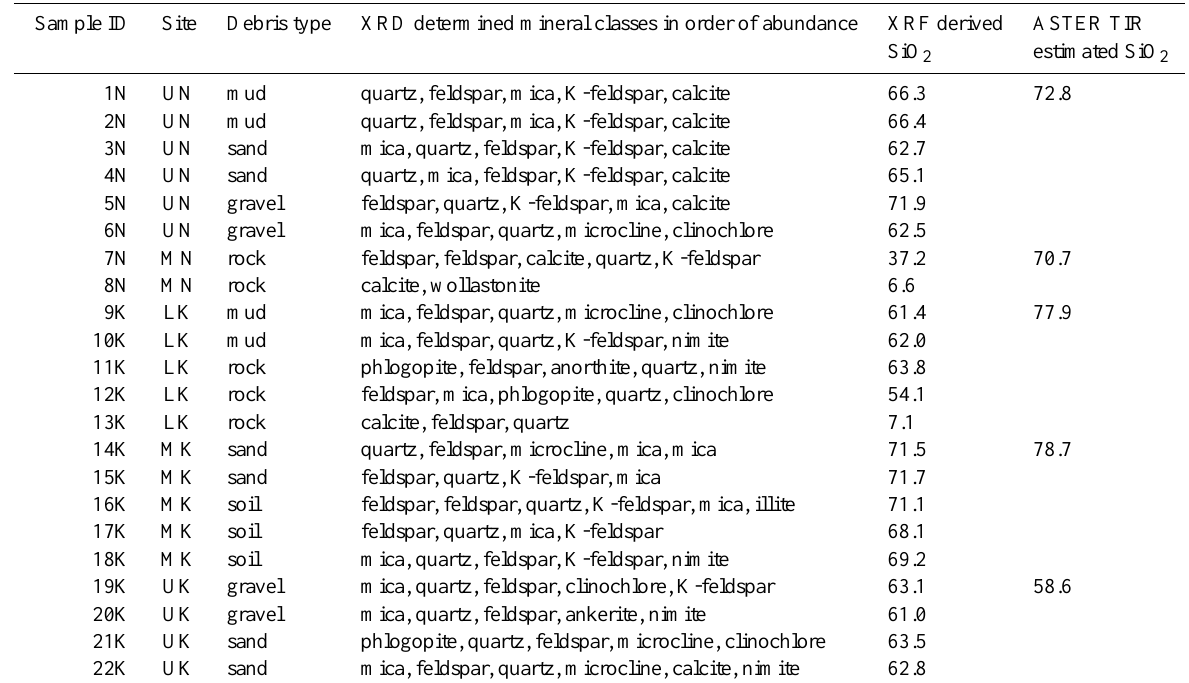
Table 3. In situ and satellite comparison of mineralogy and silica abundance at Ngozumpa and Khumbu glacier sample locations. XRD- derived minerals are listed in order of greatest abundance per sample, along with XRF measured SiO 2 weight percent and ASTER TIR estimated SiO 2 weight percent. ASTER TIR SiO 2 weight percent is averaged from the nearest two 90 m pixels to the in situ sample